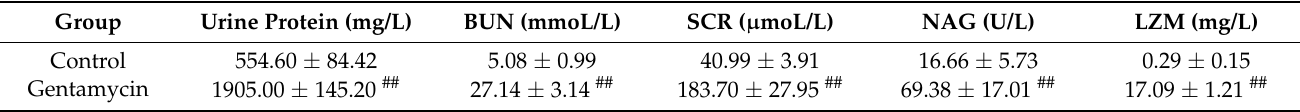
Table 1. Effect of GM injection on kidney function in rats. ( n = 6, X ± S). Group